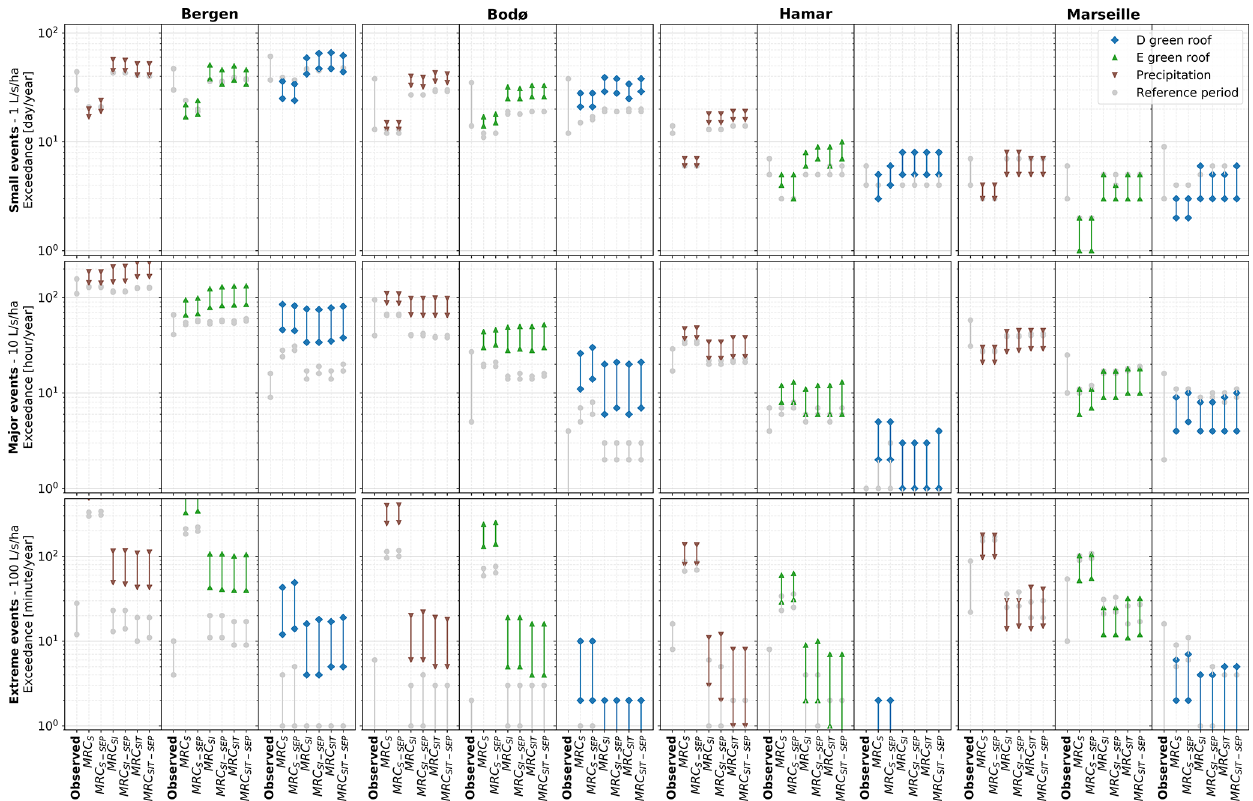
Figure 8. Future performance of green roofs (D and E) in Bergen, Bodø, Hamar and Marseille; exceedance frequency for small events, major events and extreme events. The stochastic variability linked to the downscaled time series is evaluated with the 5th to 95th percentiles. Observed represents the fine-resolution observed time series or simulation using this time series as input. The 5th to 95th percentiles were estimated with a 3-year moving window. Due to log axis, occurrences lower than 10 0 are not